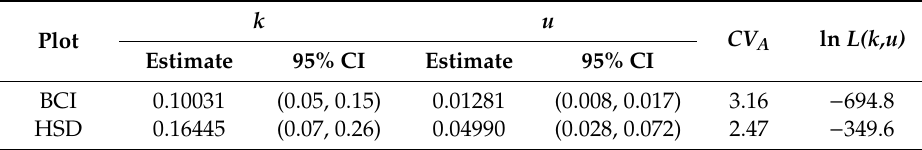
Table 1. Estimated values of k and u and their 95% confidence intervals (CI) and CV and the corresponding maximal log-likelihood values (ln L(k,u) ) for the two forest plots based on Equation (8). For the Barro Colorado Island (BCI) plot and the Heishiding (HSD) plot, the whole plot size was the same as A = 50 ha.